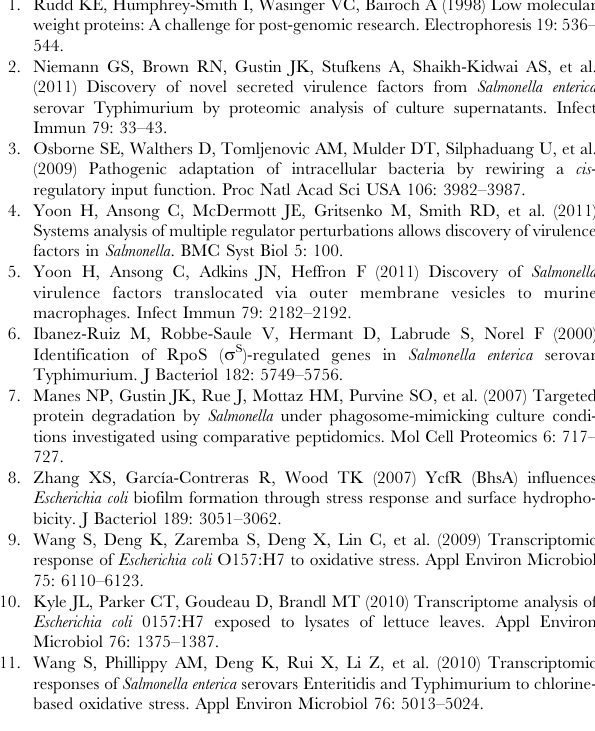
Figure S4 1 H- 15 N HSQC spectra of SrfN titrations with ligands. SrfN monomer concentrations are indicated, while the final ligand:SrfN dimer molar ratios are given in parentheses. A